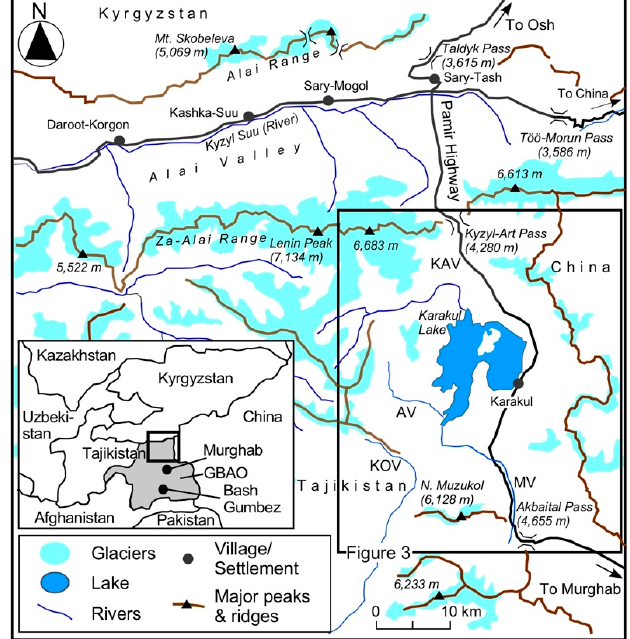
Figure 1. The study area. KAV: Kyzyl-Art Valley; AV: Akjilga Valley; KOV: Kokuibel Valley; MV: Muzukol Valley.